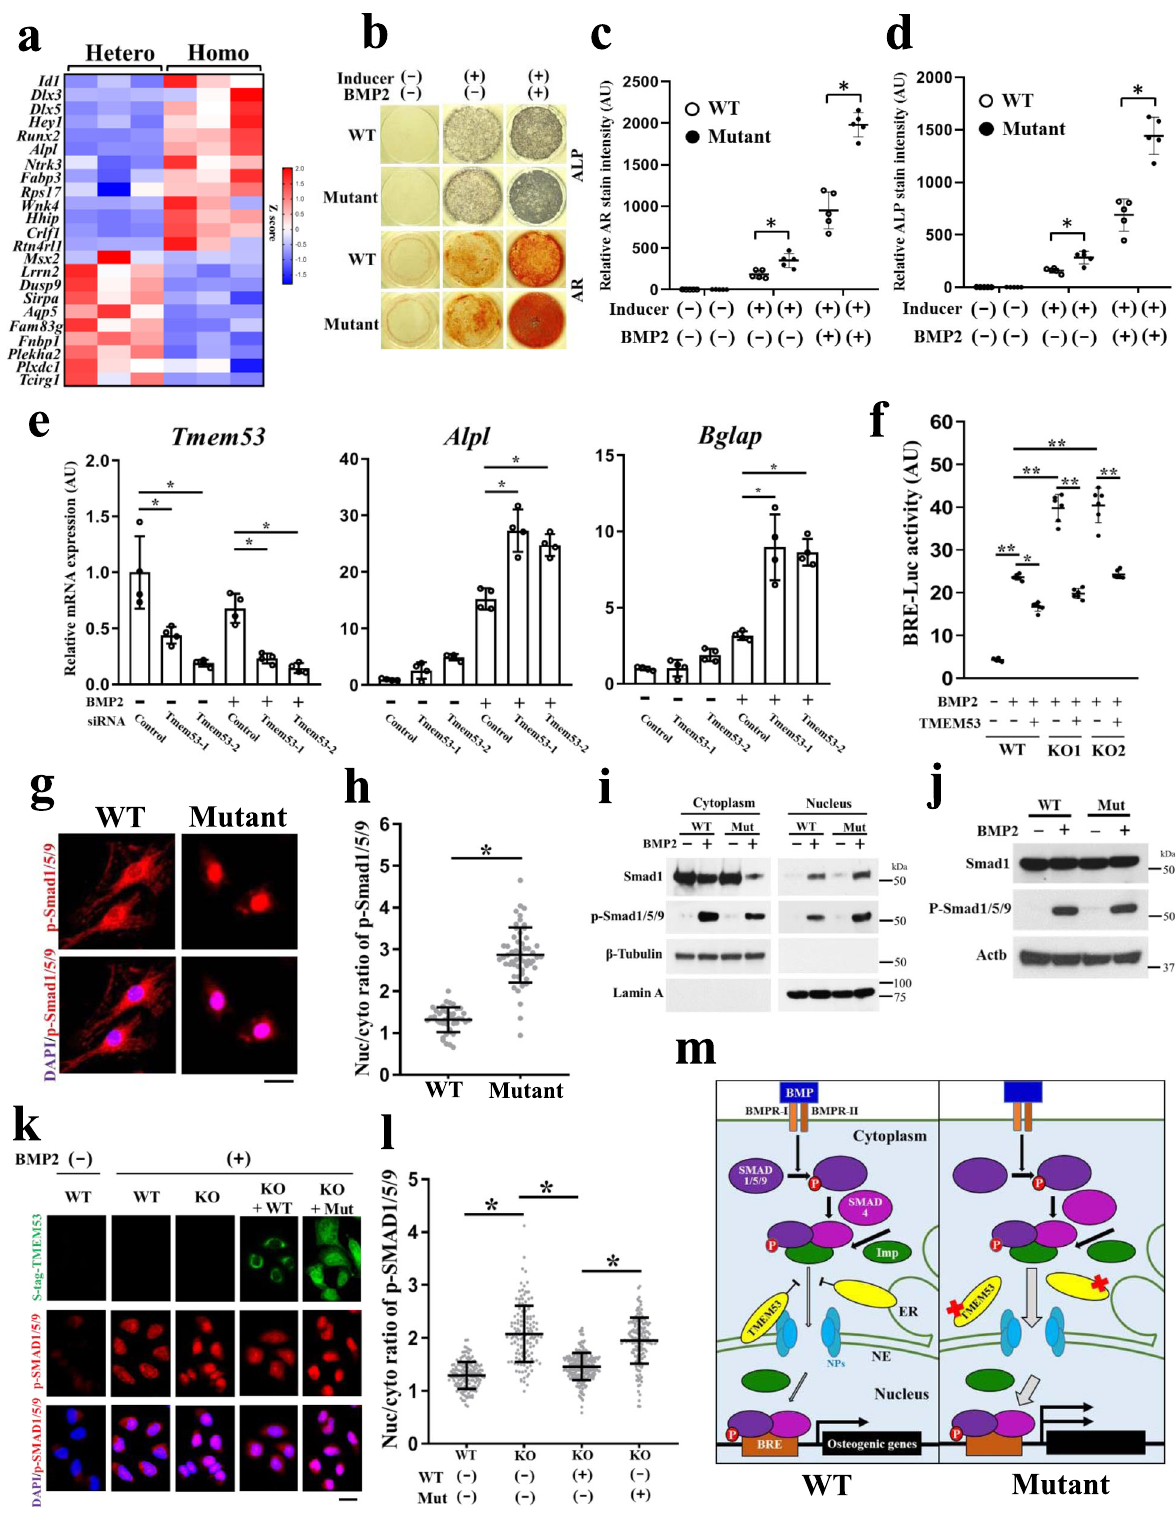
phosphorylated Smad1/5/9 in primary calvaria cells stimulated with BMP2. We found that phosphorylated Smad1/5/9 increased in the nucleus and correspondingly decreased in the cytoplasm (Fig. 5g, h), and those fi ndings were supported by Western blot analysis of the cytoplasmic and nuclear protein extracts (Fig. 5i and Supplementary Fig. 13). In contrast, the whole-cell lysate did not show signi fi cant changes in the phosphorylation levels of